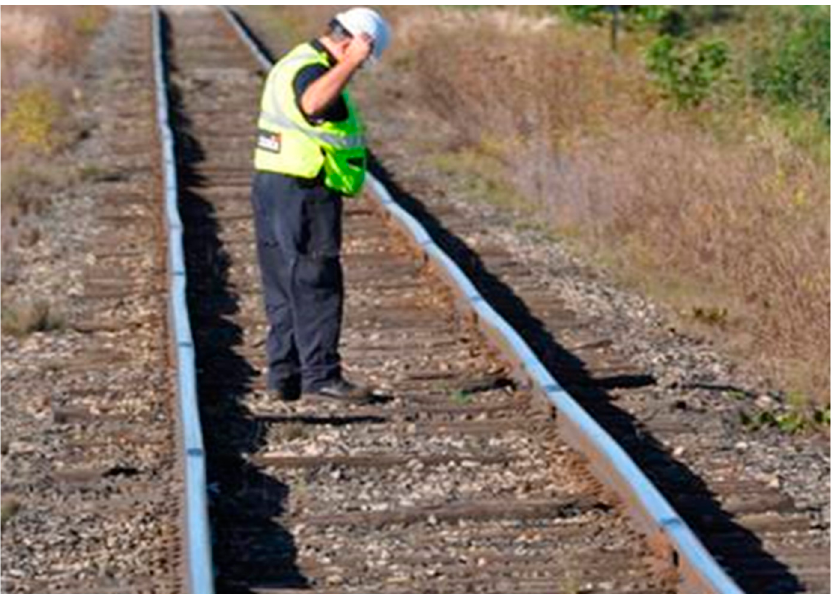
Figure 3. Original time histories of acceleration on two sides of a vehicle.